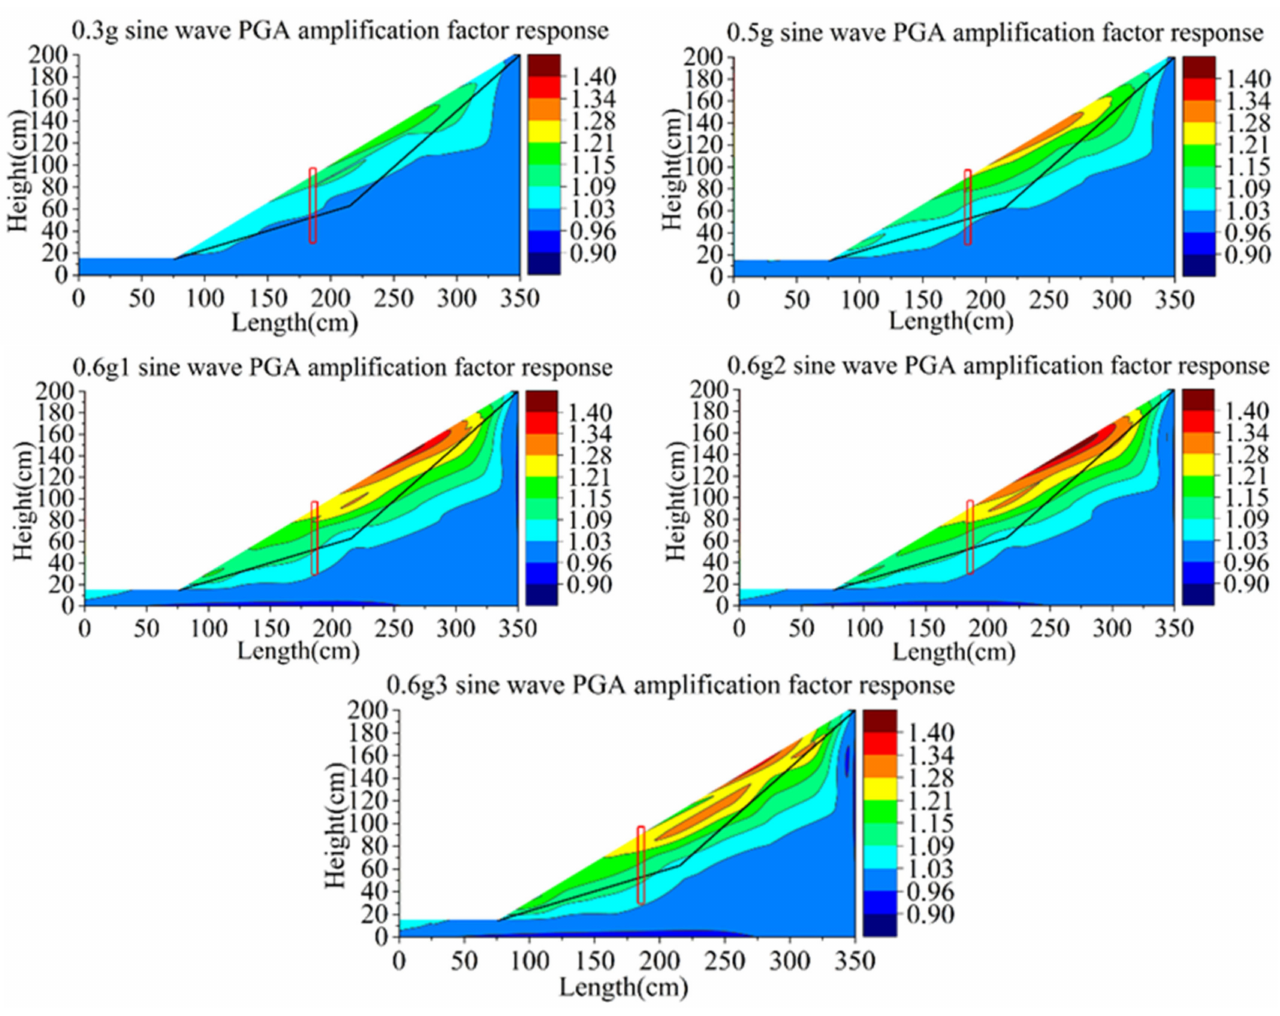
Figure 16. Contours of PGA amplification coefficient of model C. Compared with point J3 before the pile, the acceleration amplification factor of J6 be- hind the pile is between 1.05 and 1.10, which is smaller than that of J3 before the pile, indicating that the anti-sliding pile has a greater effect on the sliding limit of the soil near the sliding surface behind the pile than the soil before the pile, and the local damping reduction speed is slower than that near the front sliding surface of the pile. For J7 behind the pile, the two groups of A and B are similar to J4 before the pile, and the maximum values are between 1.23 and 1.25. Compared with groups A and B, J6 of group C was significantly increased, while that of J4 on the front slope of the pile was significantly decreased. It shows that when the initial quality of the anti-sliding pile is poor, the soil on the slope behind the pile will undergo local slip accumulation, resulting in a decrease in the damping of the soil near the slope behind the pile, and an increase in the PGA nonlinearity. However, the position of J4 in front of the pile is located on the free surface, and the anti-sliding pile cannot provide sufficient energy dissipation effect. Under the action of the most unfavorable acceleration, the soil on the slope surface repeatedly shears and dissipates energy, resulting in the obviously decreasing acceleration amplification factor trend relative to the A and B